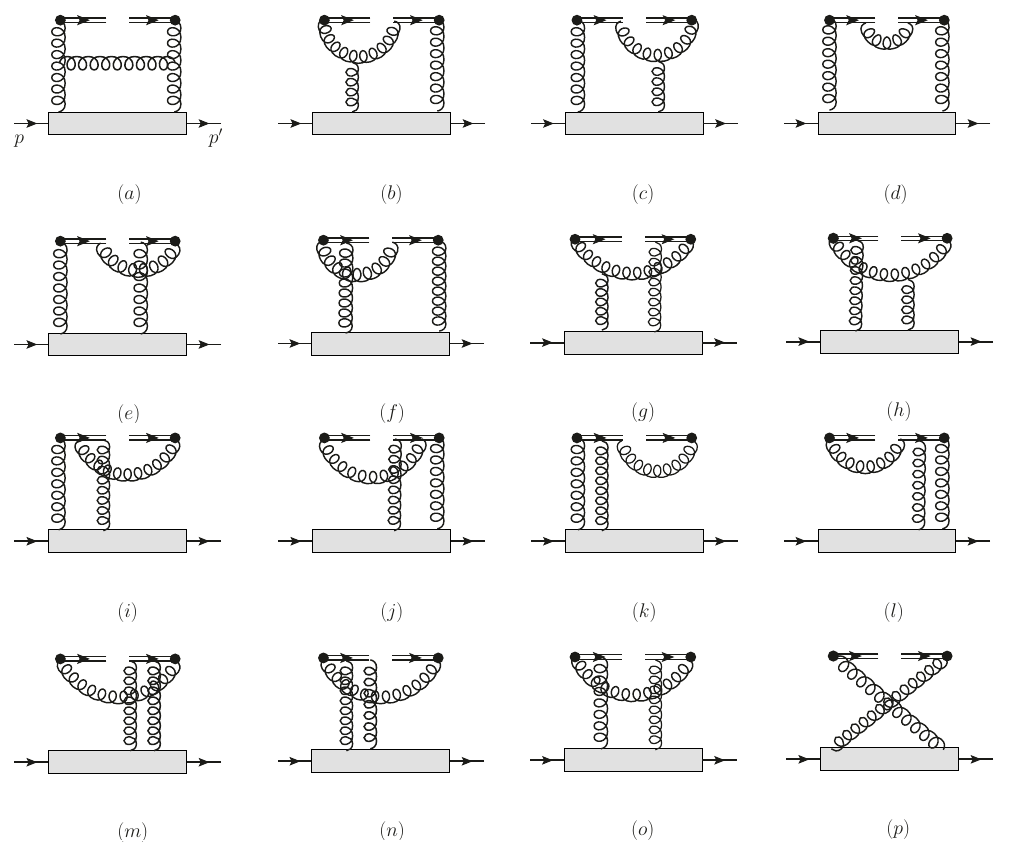
Figure 2 . The one-loop diagrams for real corrections to quasi GPDs. In the last diagram there is a four-gluon vertex in the middle.